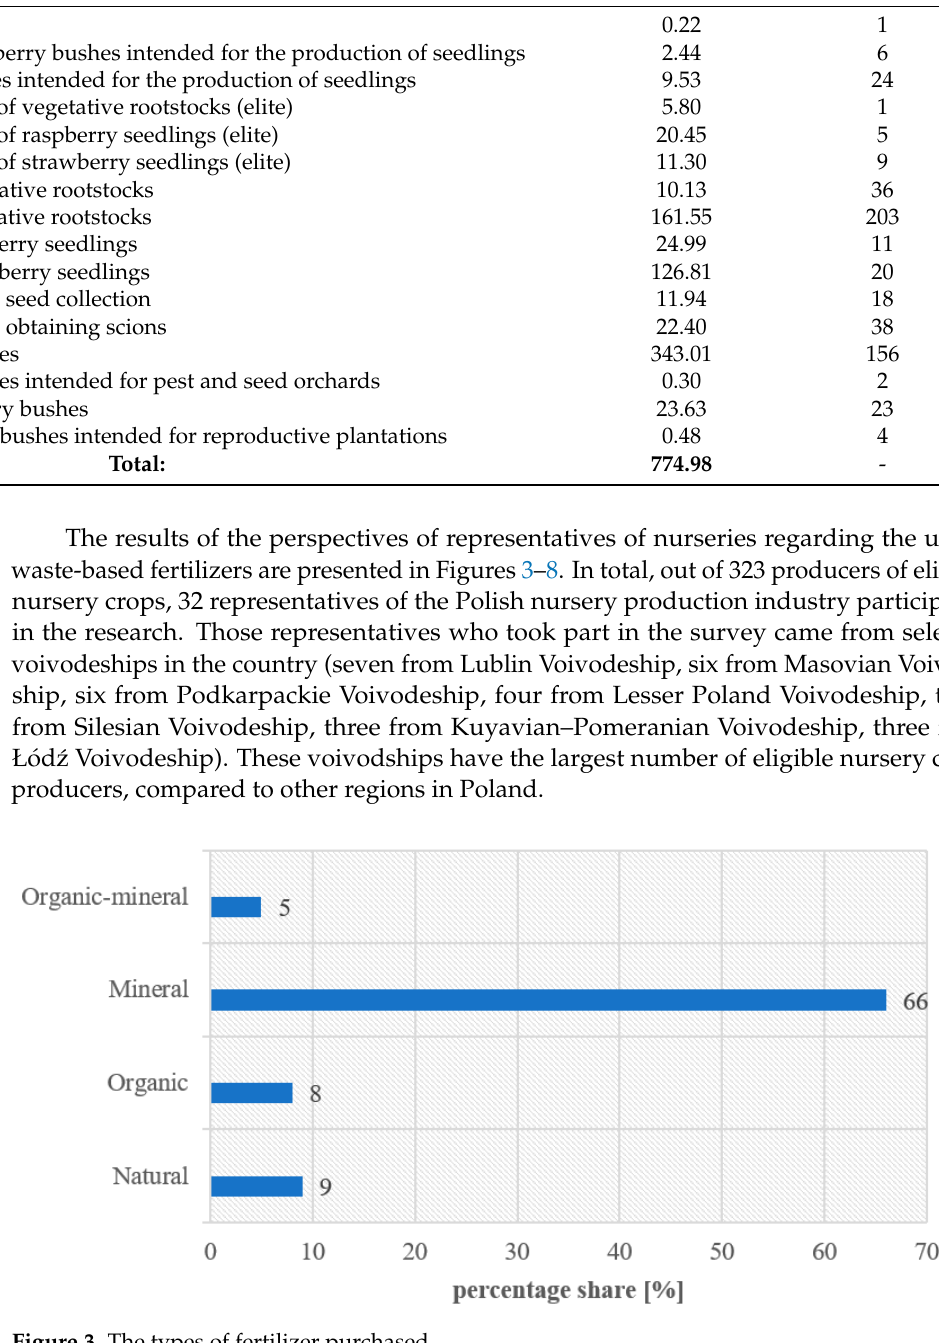
Figure 3. The types of fertilizer purchased.